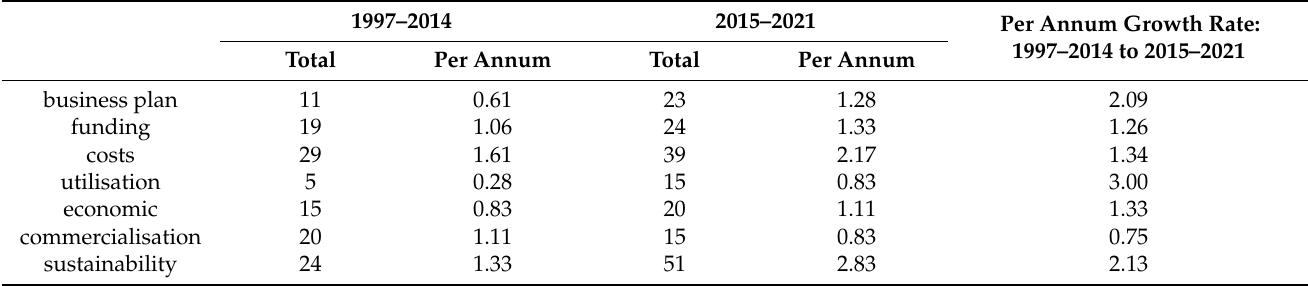
Table 2. The occurrence of the top seven topics in the